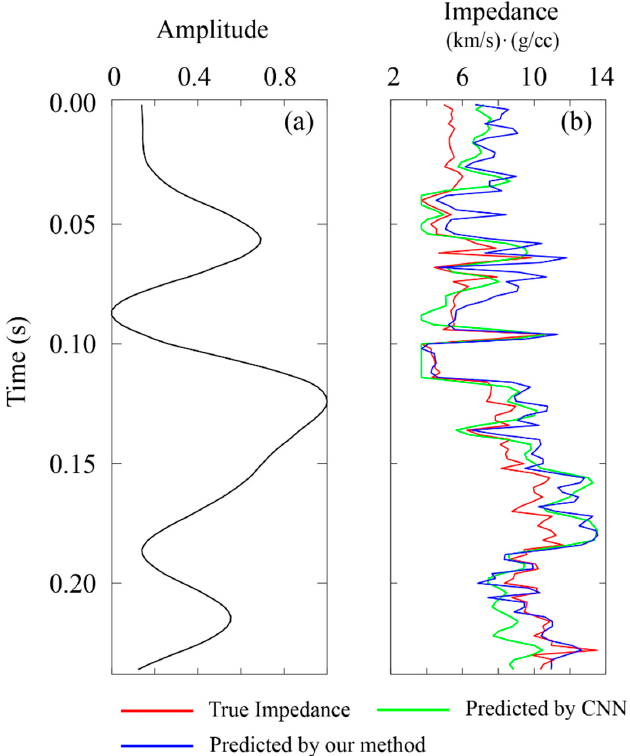
Figure 10. ( a ) Input seismic data along well and ( b ) true impedance (red line), impedance predicted by CNN (green line) and our method (blue line) along the well. The correlation between true impedance and impedance predicted by our method is 0.88 which is higher than 0.82 in [25].